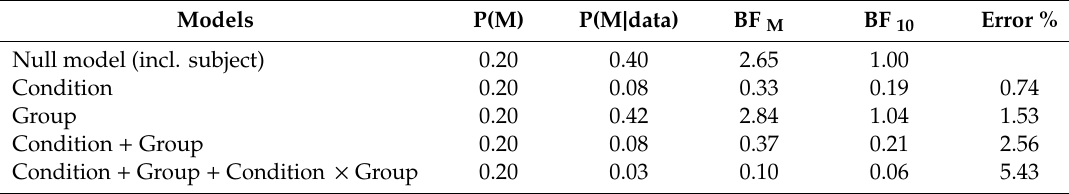
Table 2. 2 × 3 Bayesian ANOVA for motivation (two levels: single-gain , competitive-gain ; three levels: training, single, and competitive multi-user conditions).